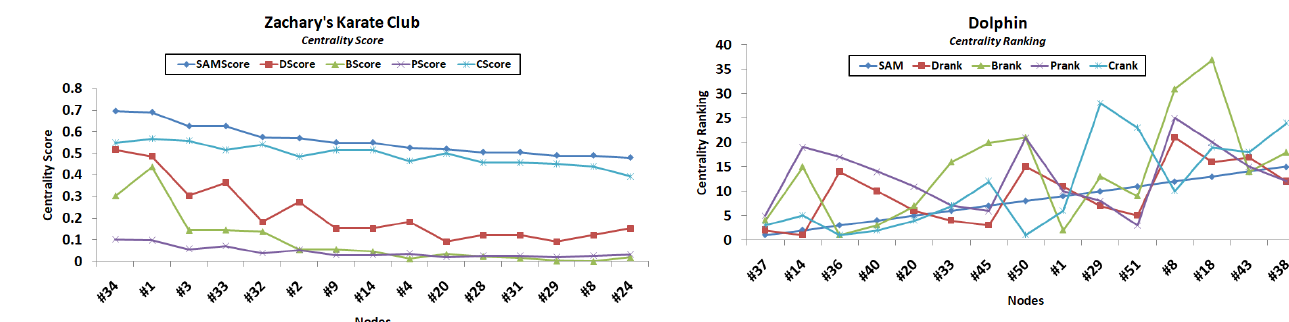
Figure 5. Centrality score of top 15 nodes from Zachary‘s Karate Club, sorted by SAM centrality link indicate the frequent interaction between nodes.